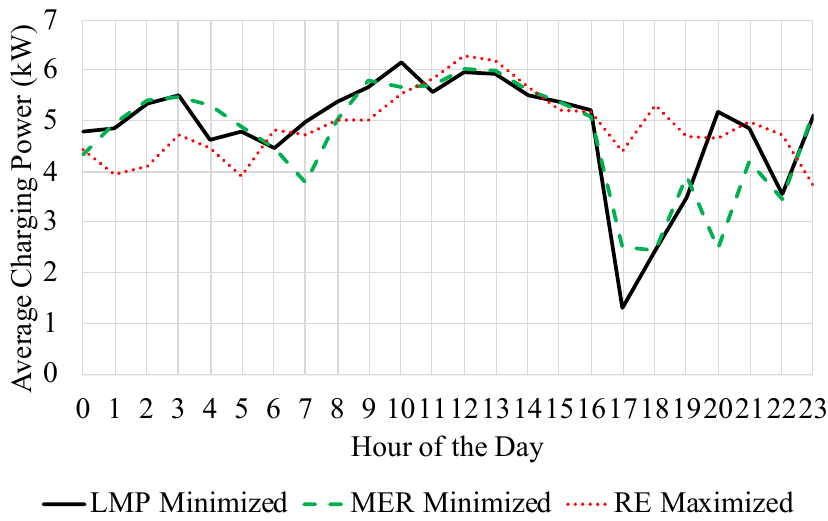
Figure 9. Optimal charging power of various objective functions (inter-location